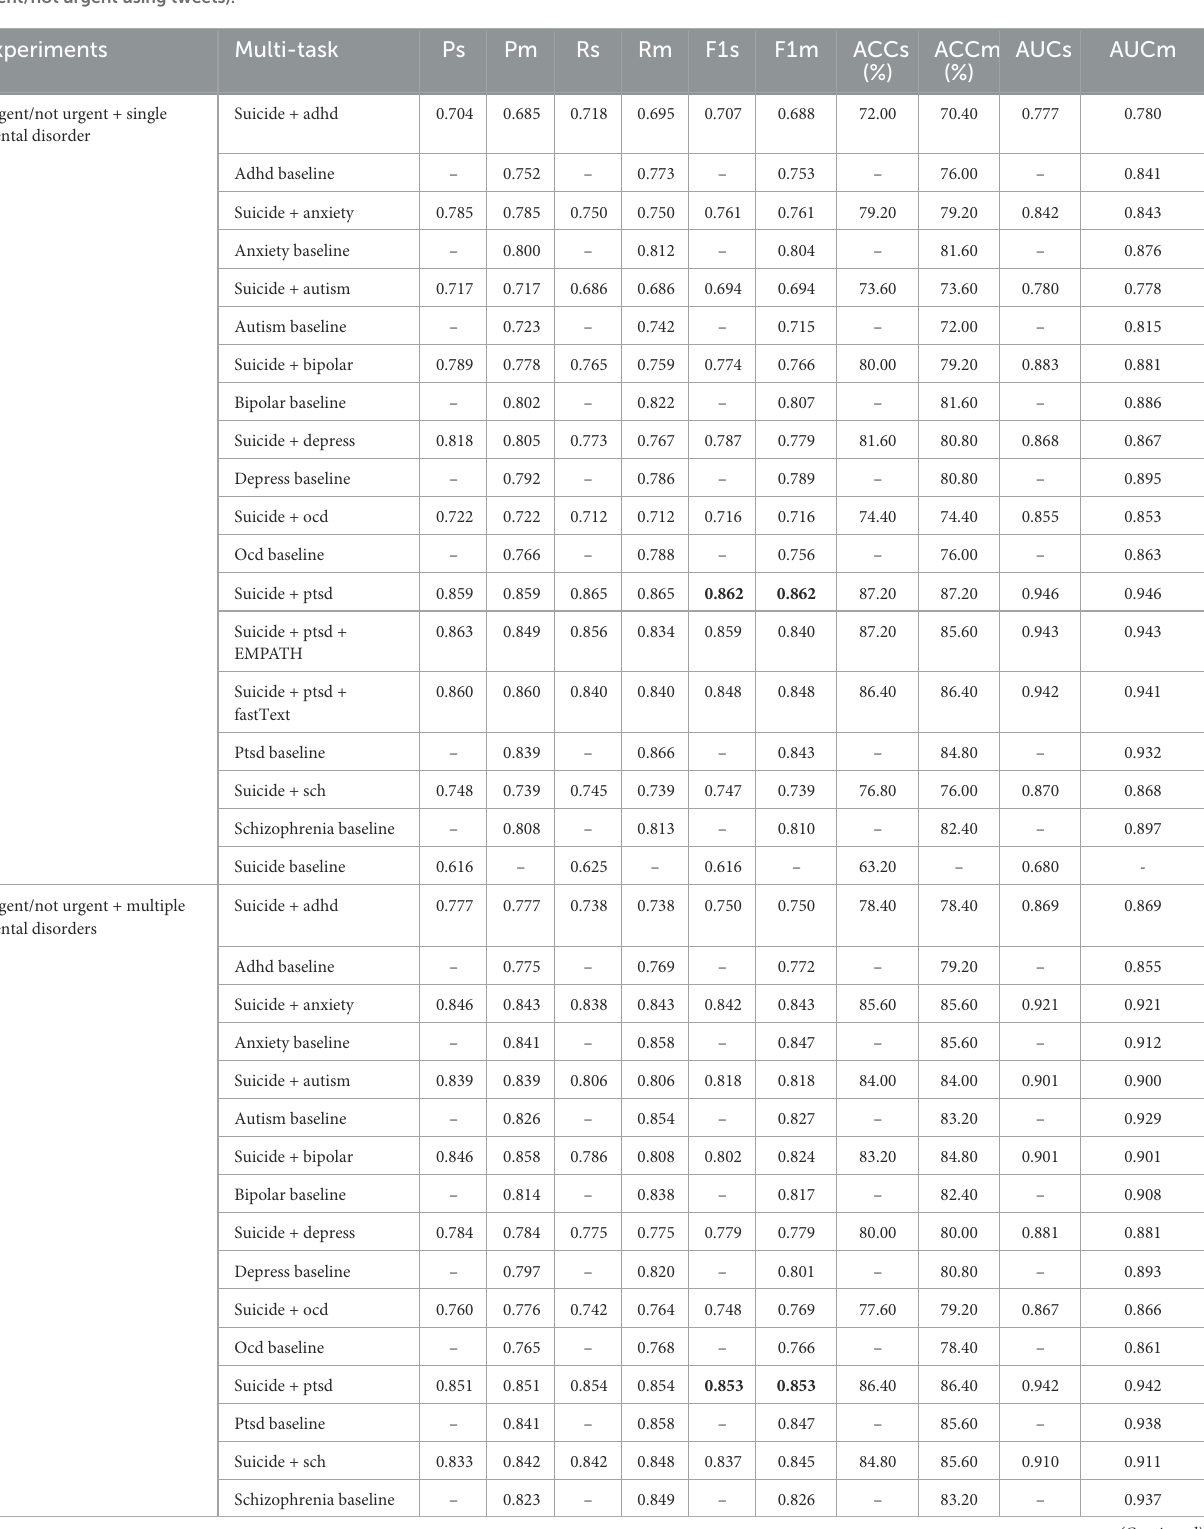
TABLE 8 Experiments: urgent/not urgent with users self-diagnoses with a single mental disorder (urgent/not urgent + single mental disorder), urgent/not urgent with users self-diagnoses with multiple mental disorders (urgent/not urgent + multiple mental disorders), urgent/not urgent with users diagnosed only with PTSD and evaluated on the expert annotated data (expert), urgent/not urgent with users diagnosed with PTSD or depression (urgent/not urgent using tweets). Experiments